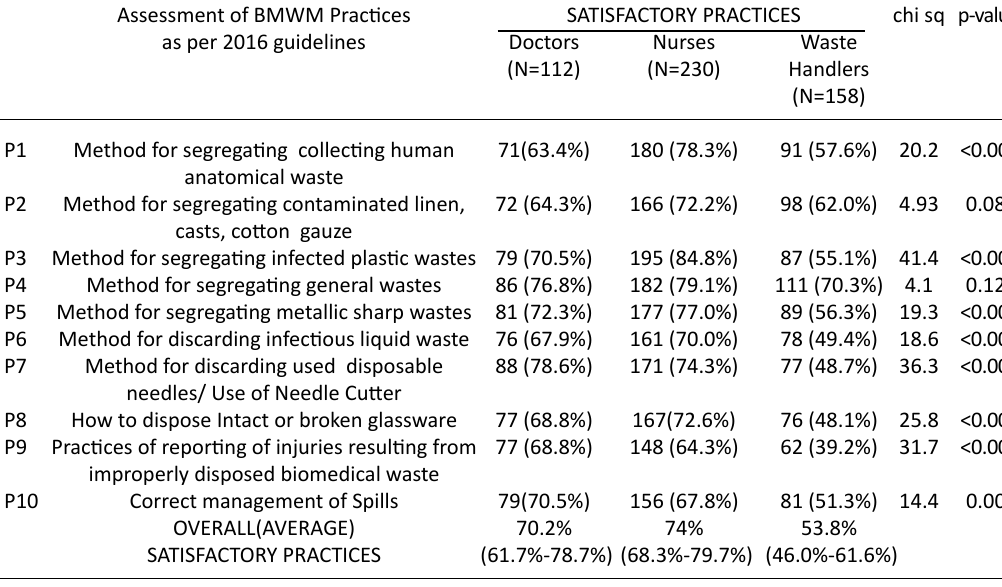
Table 3. BMWM awareness of existing practices among healthcare personnel Assessment of BMWM